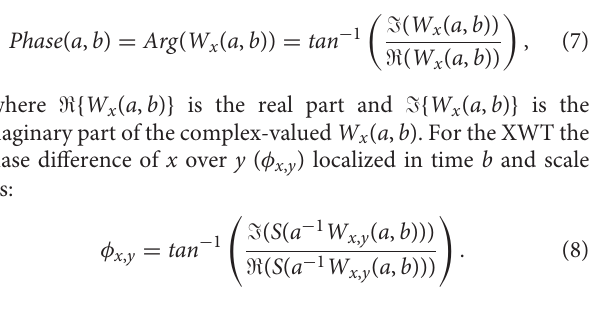
displacement of periodicity in the interval [- π , π ] is,